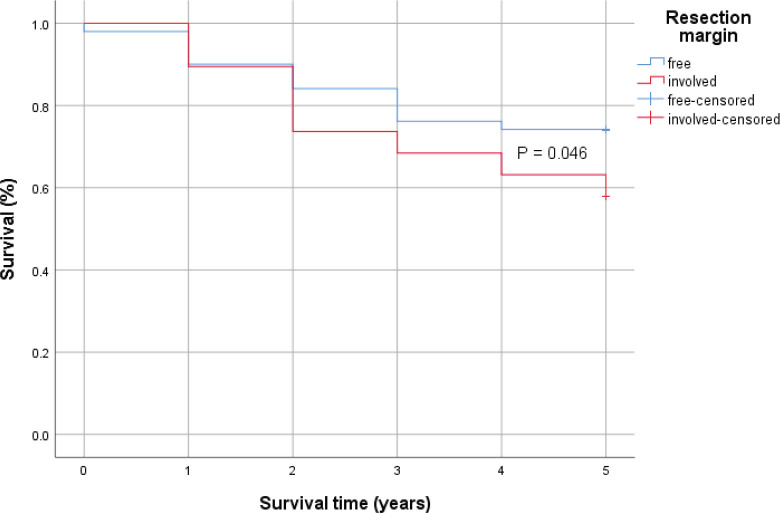
Kaplan–Meier survival curve comparing the 5-year survival of patients with positive resection margin (Red) and those without (Blue) with 0.046 p-value by log-rank test.